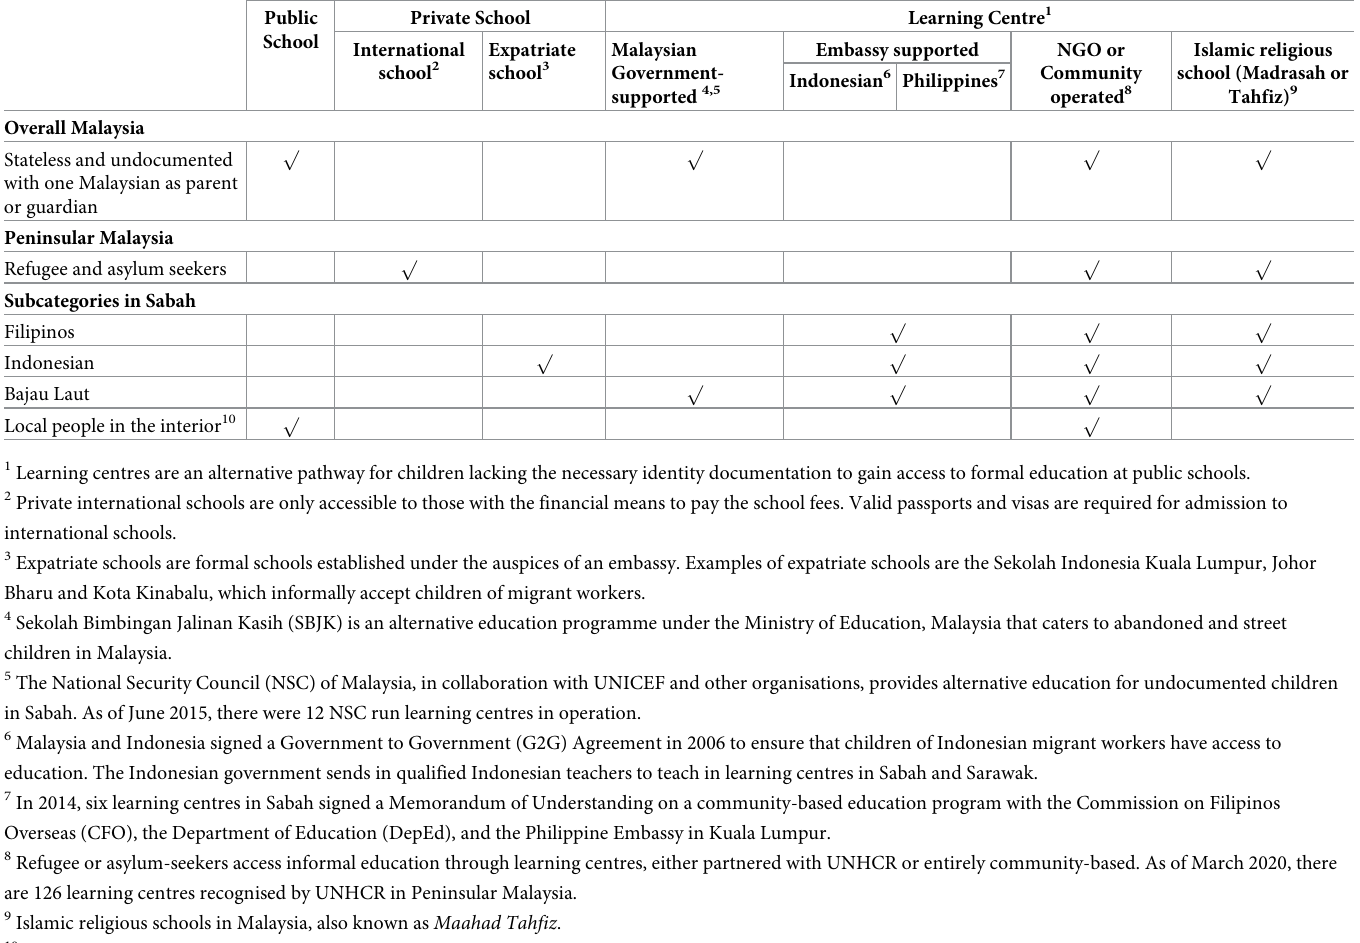
Table 2. Types of education access for undocumented and non-citizen children in Malaysia. Categories of non-citizens children in